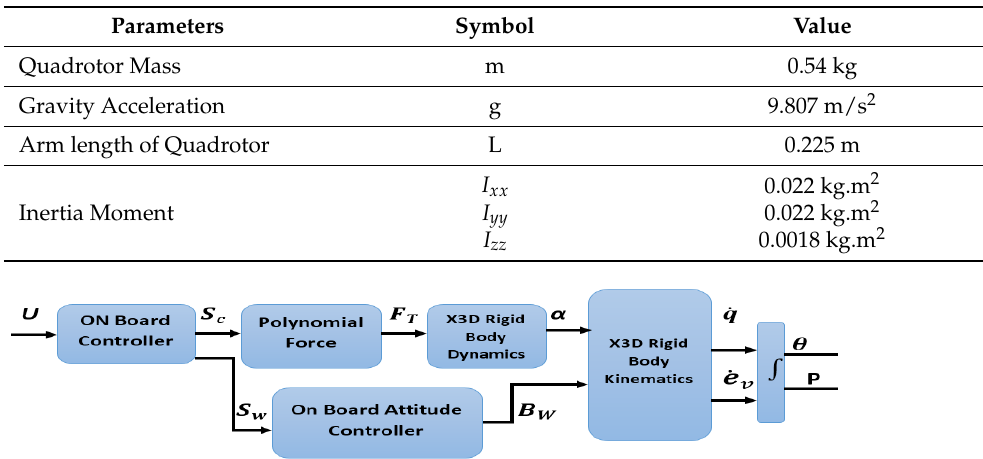
Table 2. X3D Quadrotor parameter list.